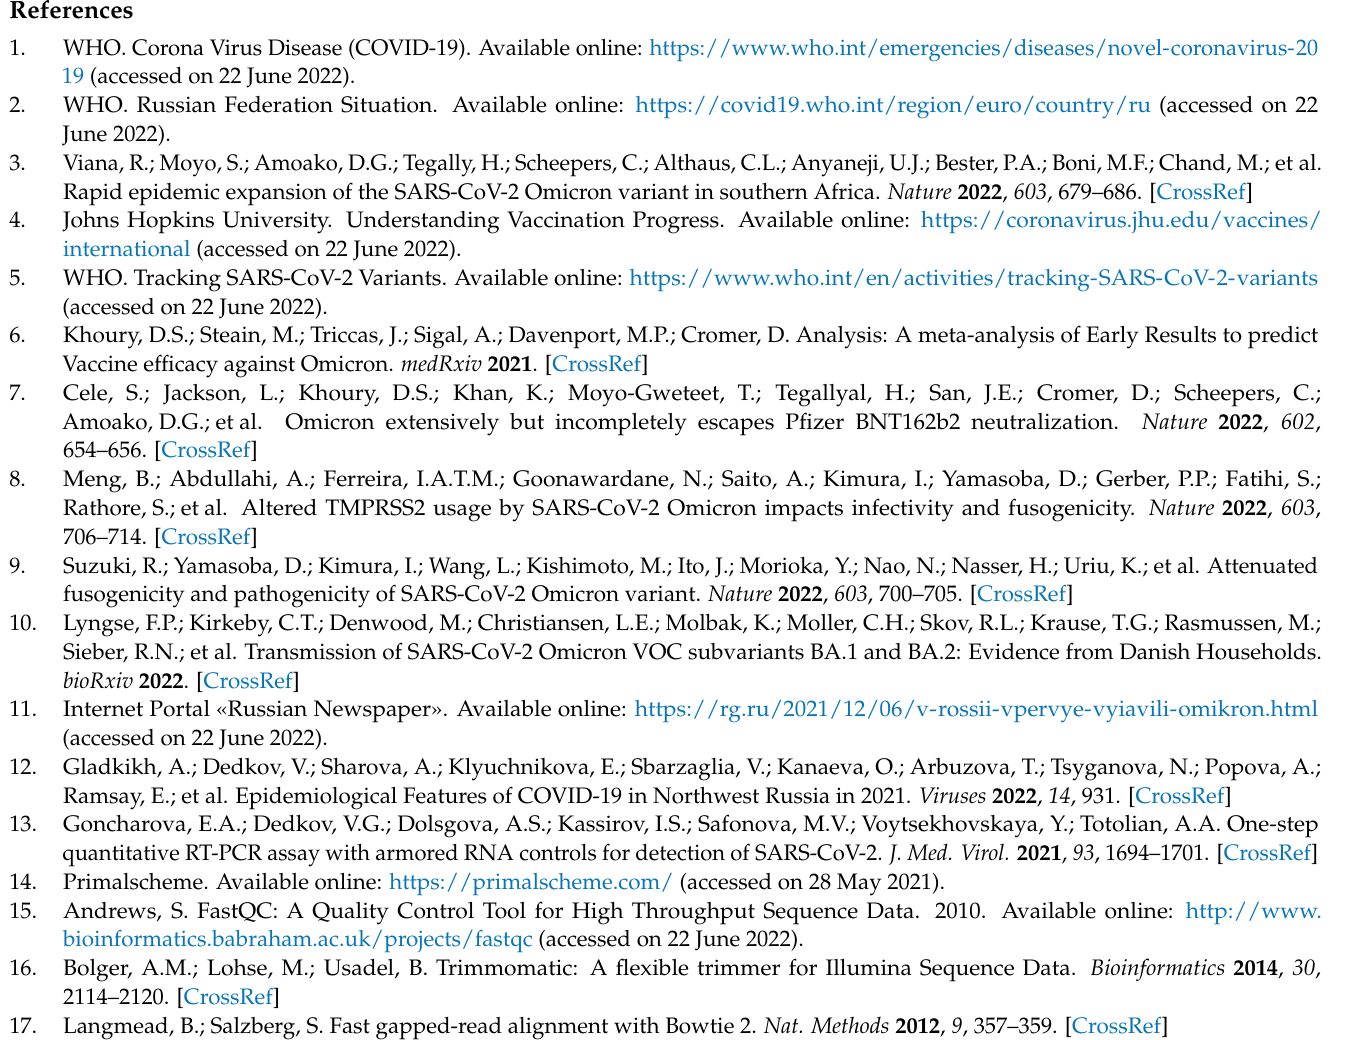
the study; Table S2: SARS-CoV-2 variants used for phylogenetic tree; Table S3: Passenger information for confirmed Omicron BA.1